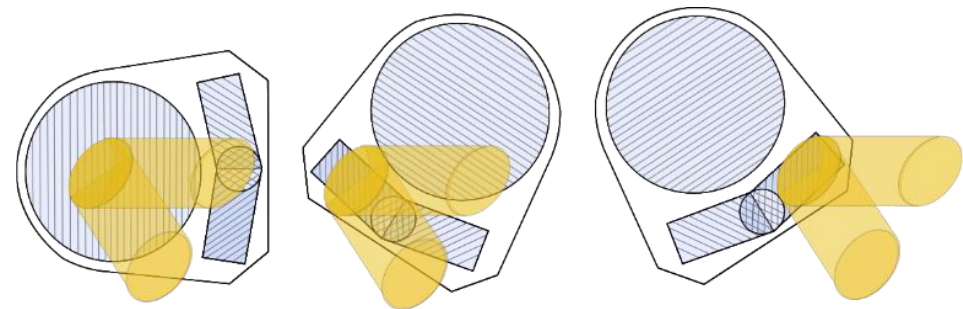
Figure 9. The location of the substrate when recording different DOEs.